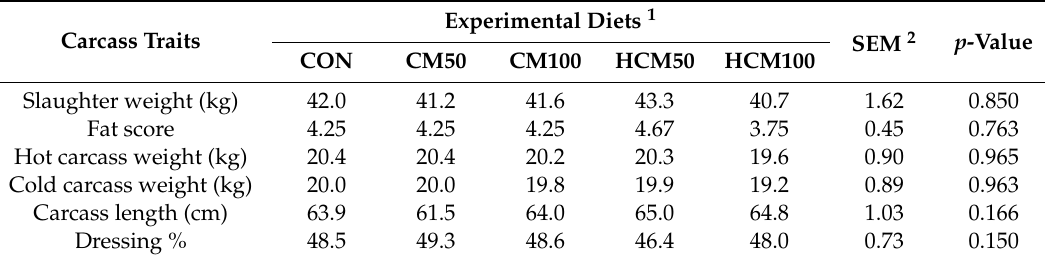
Table 6. E ff ect of partial or complete replacement of dietary soybean meal with untreated or heat-treated canola meal on carcass traits of Meatmaster